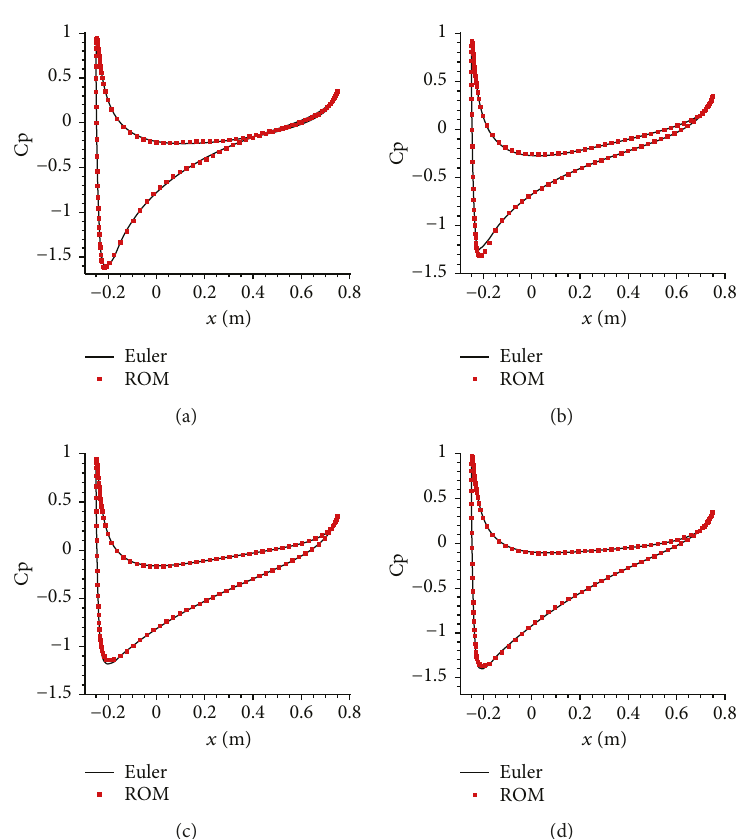
Figure 6: Pressure distribution predicted by the Euler and ROM at (a) T/4, (b) 2T/4, (c) 3T/4, and (d) T when f = 65 Hz.